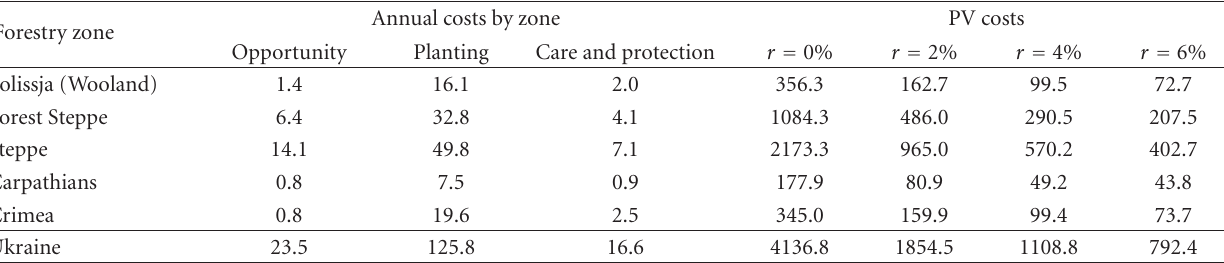
Table 3: A ff orestation costs, MC.